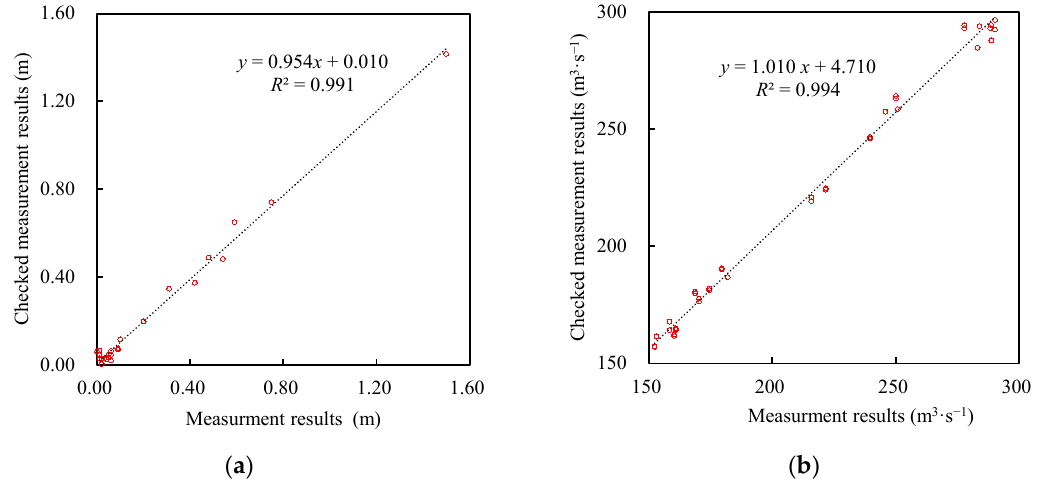
Figure 4. Comparison of the tested results in the project itself and the checked measurement results in this study: ( a ) water level difference between inlet and outlet and ( b ) flow rate.